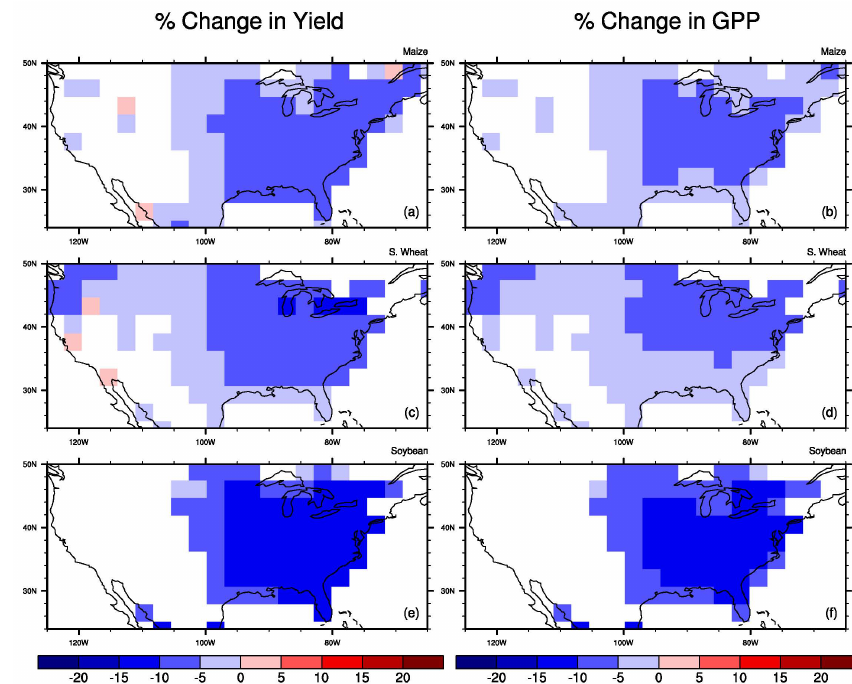
Fig. 12. The percent change in yield (left column) and GPP (right column) for (a, b) maize, (c, d) spring wheat, and (e, f) soybean from a 10% residue return management practice